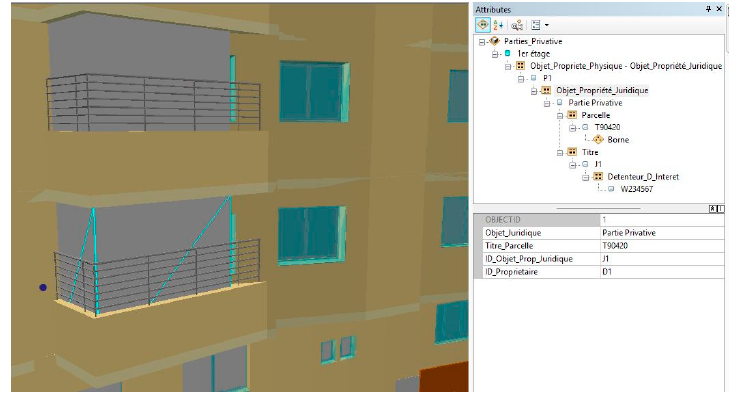
Figure 14. Available information on a selected private area.